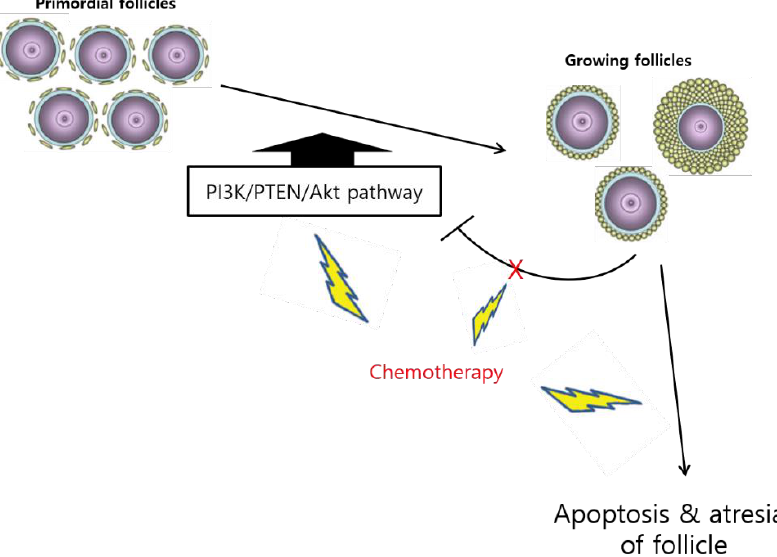
Figure 2. “Burnout” theory of ovarian follicle reserve. The chemotherapy-induced PI3K/PTEN/Akt pathway activates the destruction of follicles, followed by an impairment of AMH and the loss of the suppression of the primordial follicle (PF) pool. Consequently, the PFs are activated to compensate for the decrease in the number of growing follicles.